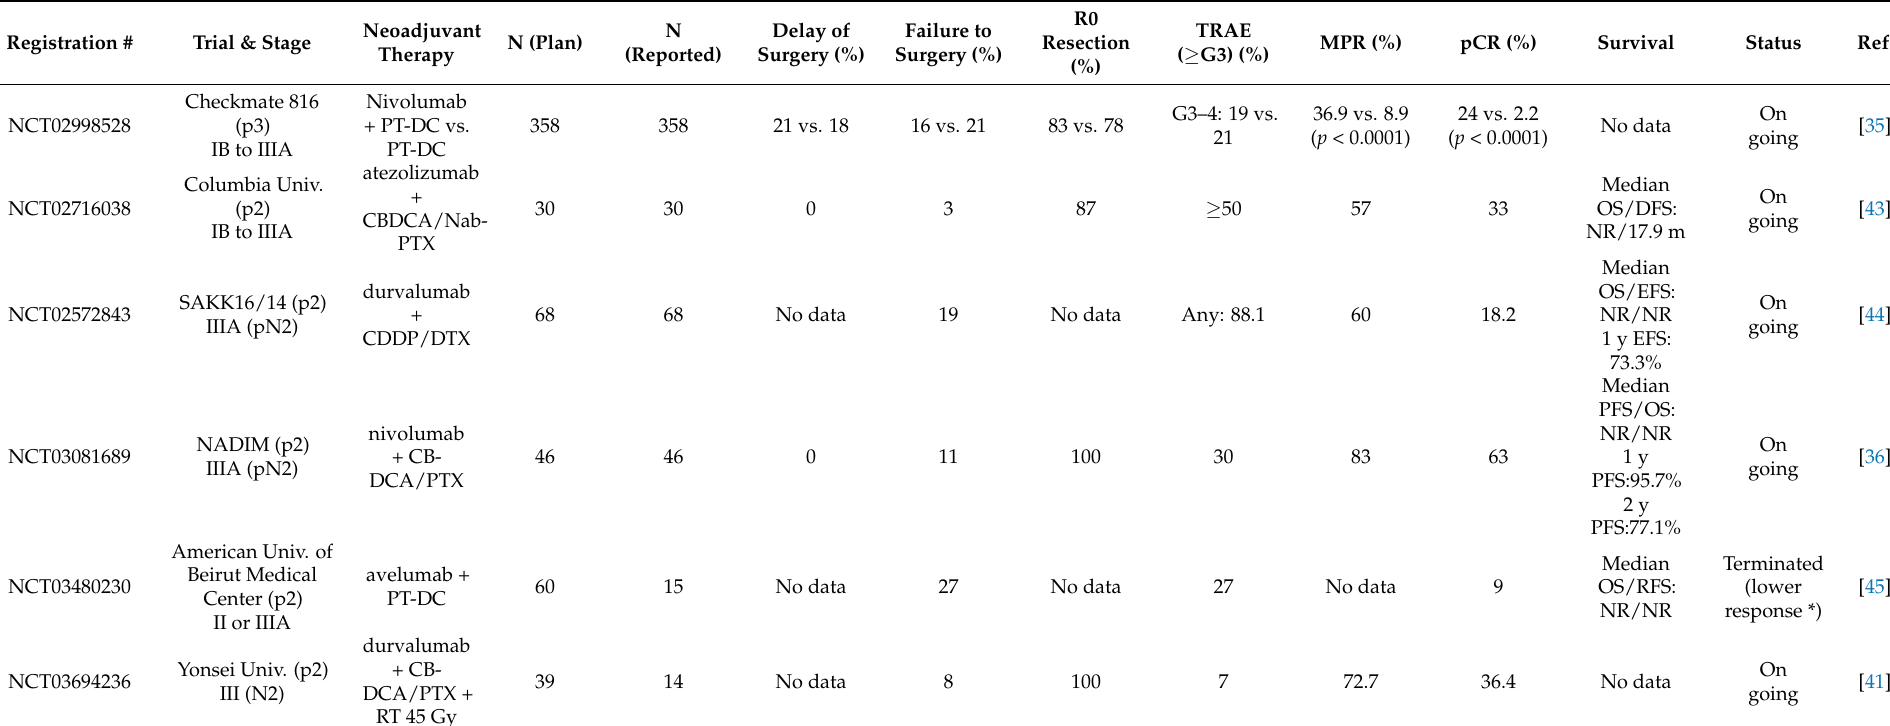
Table 3. Results of clinical trials of neoadjuvant therapy of combination regimens of